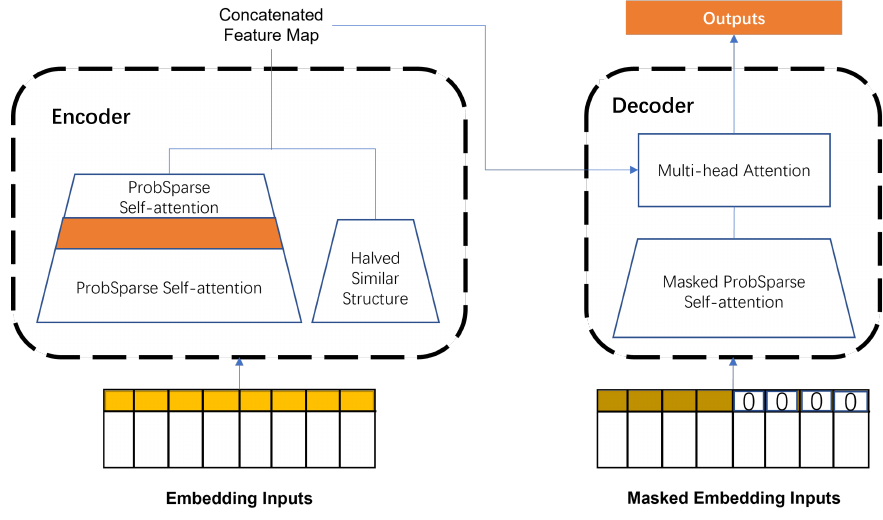
Figure 5. Temporal Informer layer